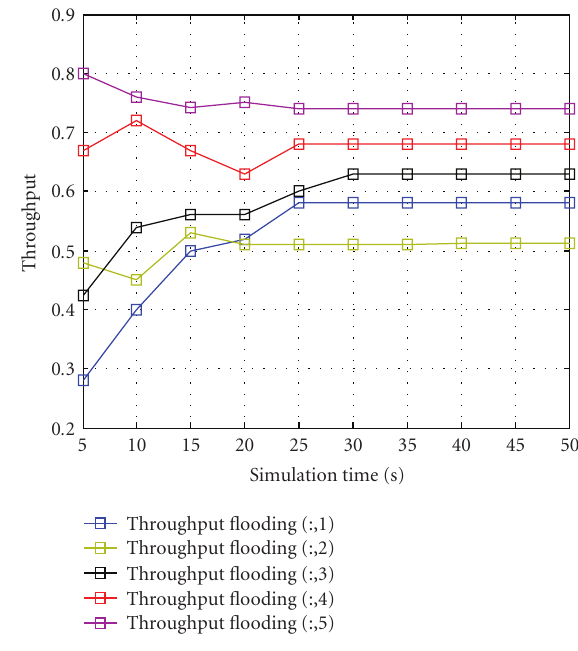
Figure 5: Simulation time and throughput.